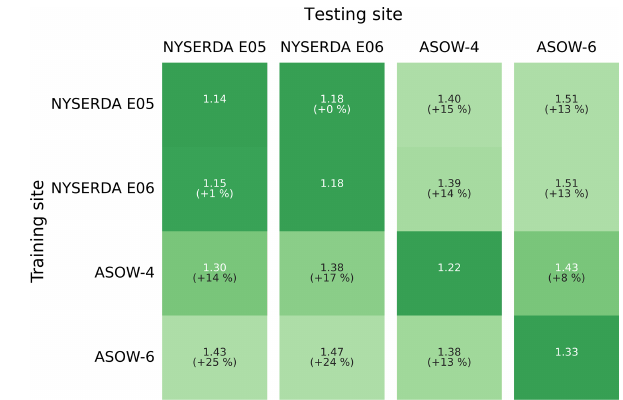
Figure 3. Testing root-mean-square error (in ms − 1 ) in predicting hourly average wind speed at 140ma . s . l . for the different lidar data sets, as a function of the data set used to train the random forest.